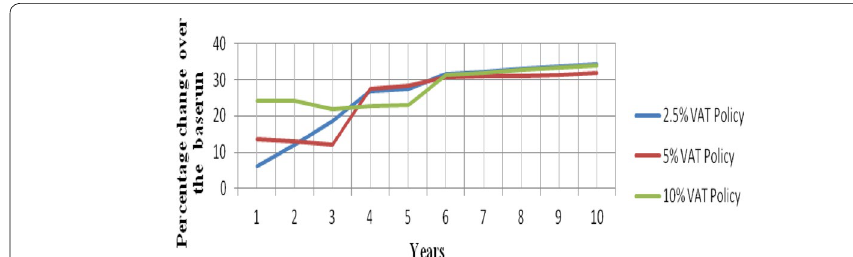
Fig. 3 Impact of VAT policy on total tax revenue